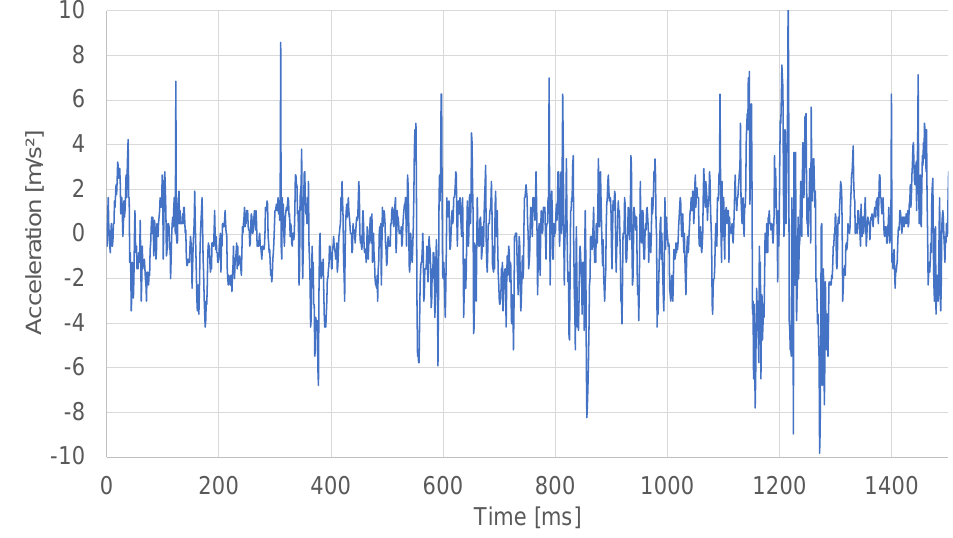
Figure 5. Parameters extracted from self-made tile texture, e ( x )